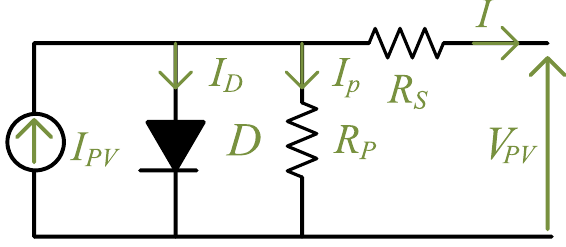
Figure 12. Equivalent circuit of a PV